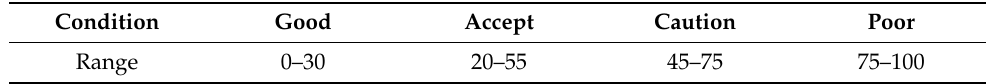
Table 5. Output ranges of fuzzy membership function of key gases.